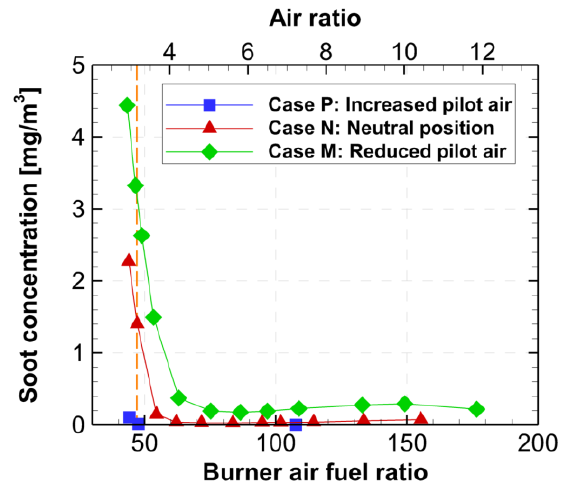
Figure 10. Soot concentration under idling conditions. (Copyright by ASME — "Effects of Fluidic Control of Air-Flow Distribution on Staged Lean Jet Engine Burner," by Yoshida, Schneider, Hassa, Paper No: GT2016-57453).